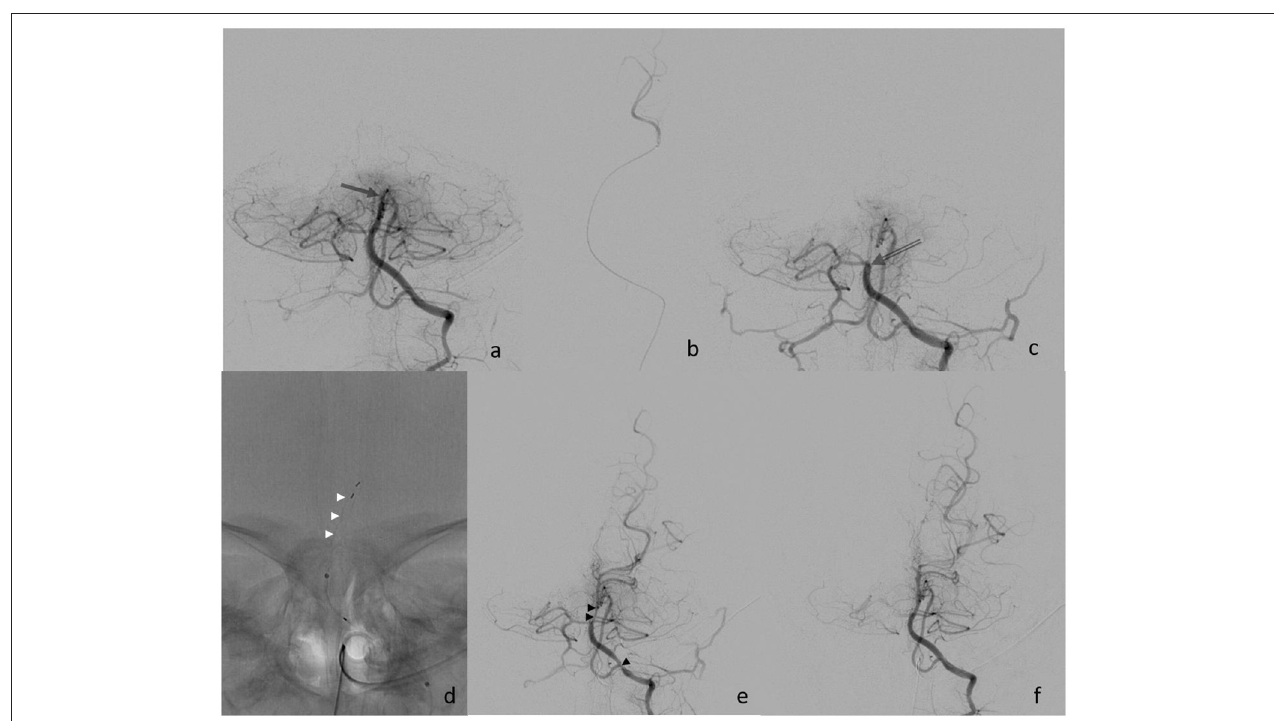
FIGURE 2 | (a) Initial finding of distal basilar artery occlusion (arrow); (b) super selective injection into left PCA; (c) proximal occlusion after the 1st retriever maneuver (open arrow); (d) deployment of Preset device (white arrowheads); (e) finding after the 2nd retrieval with vasospasm (black arrowheads); and (f) final control after nimodipine